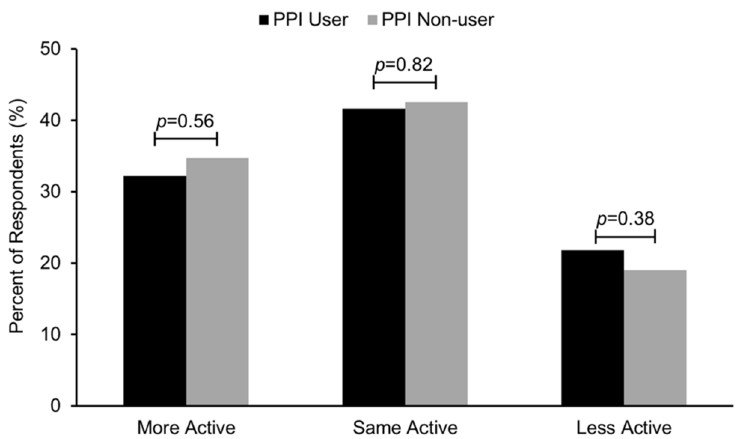
Figure 2. Self ‐ reported physical activity compared to age/gender ‐ matched peers for adult proton Figure 2. Self-reported physical activity compared to age/gender-matched peers for adult proton